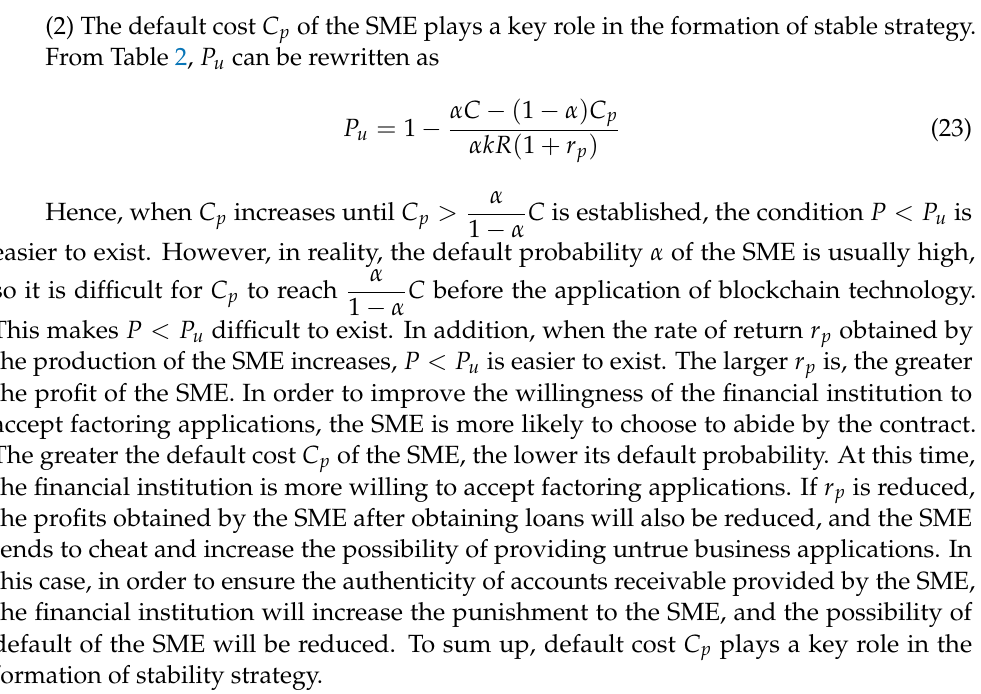
Figure 3. The mechanism of blockchain technology to resolve credit